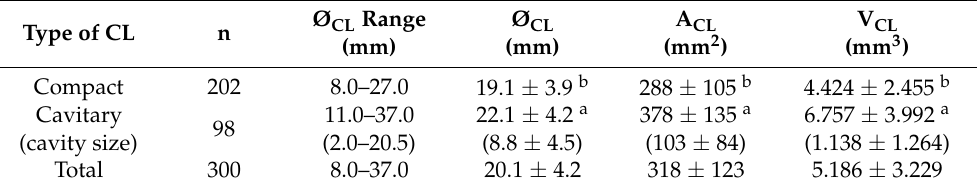
Table 1. General characteristics of quantitative parameters of CLs on days 6–8 after oestrus.